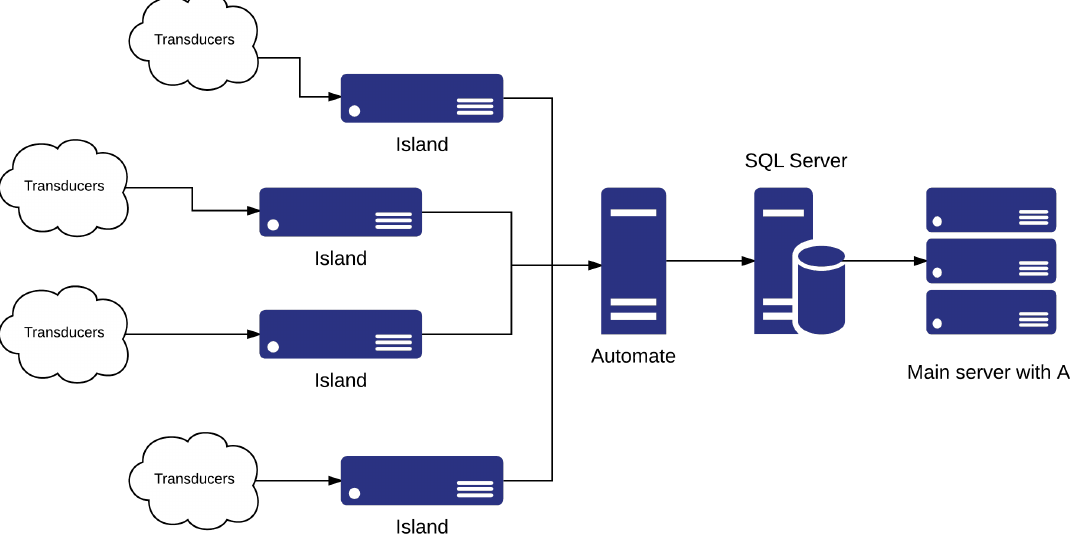
Figure 1. The Laboratoire d’Intelligence Ambiante pour la Reconnaissance d’Activités (LIARA) and Laboratoire de domotique et Informatique Mobile à l’Université de Sherbrooke (DOMUS) architecture. AI: artificial